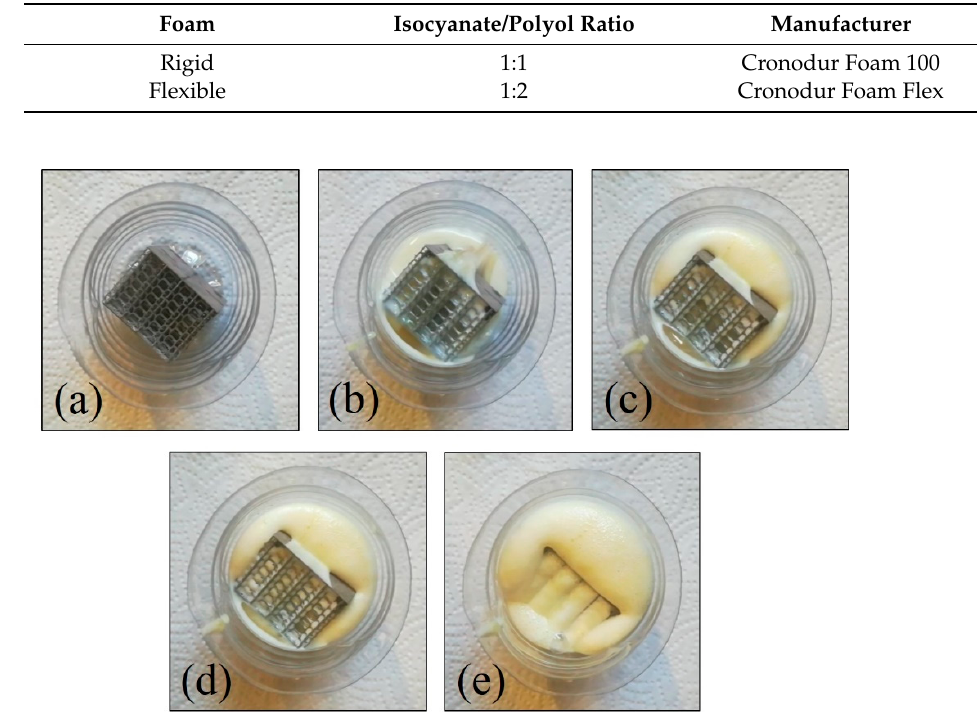
Figure 2. Sample foaming: ( a ) initial sample—t = 0 s; ( b ) pouring—t = 20 s; ( c – e ) detail of foam filling the interior of the sample—t = 30 s, 32 s and 34 s.